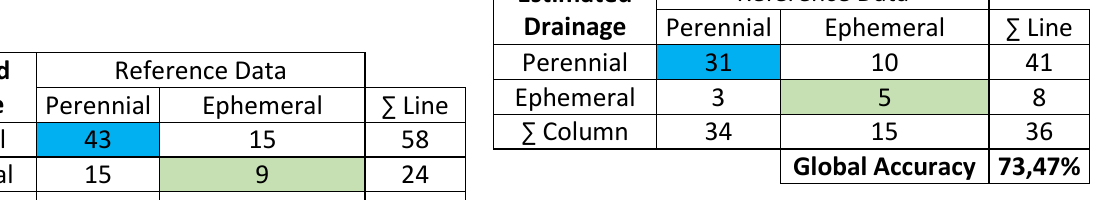
Table 3 – Accuracy Assessment of SDS/SC base in Jaguaruna.